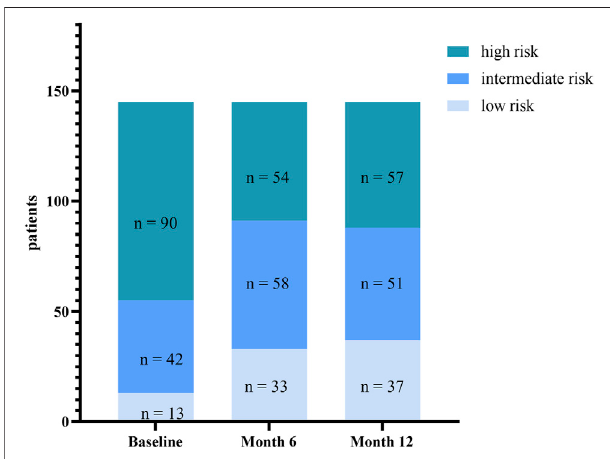
FIGURE4| Changeinriskstrati fi cation(assessedbyREVEALscore2.0) from baseline to Month 6 and Month 12.